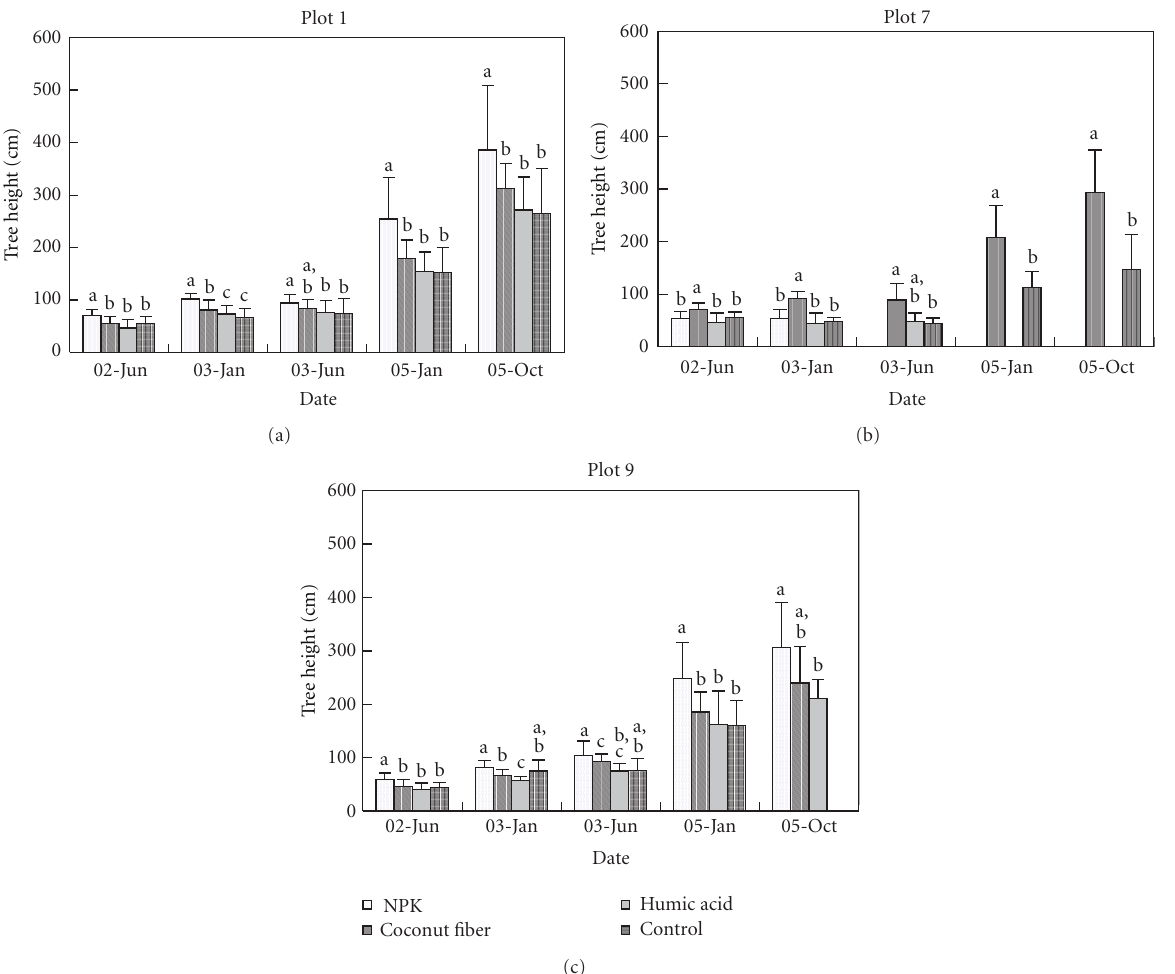
Figure 6: E ff ects of the fertilizer application on tree heights of June 2002, January 2003, Jun 2003, January 2005, and October 2005. Error bars denote standard deviation. Di ff erent letters are significantly di ff erent at P < 0 . 05 by the Tukey-Kramer